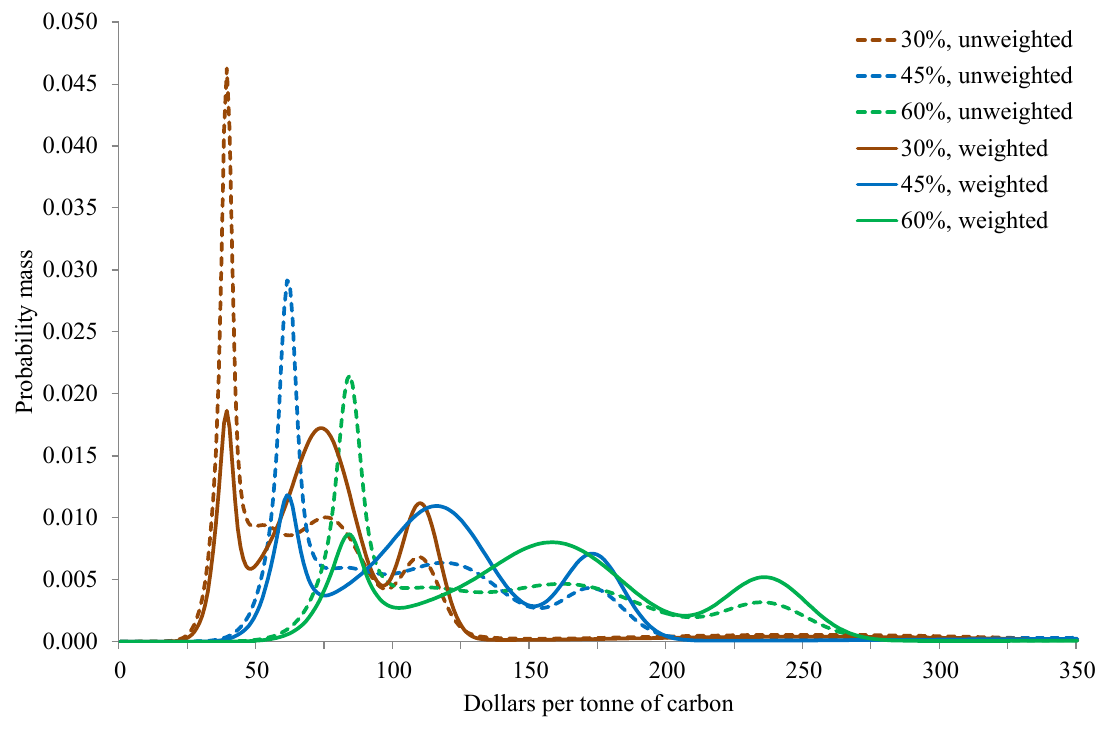
Figure 3. The probability density functions of the carbon prices, weighted and unweighted, needed for a 30%, 40% and 50% emission reduction (from base year 1990) in 2030.